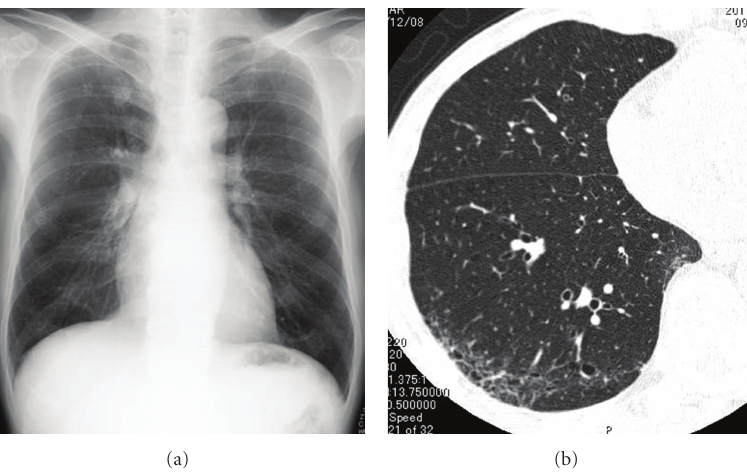
Figure 5: Airway-centered fibrosis with cysts. (a) Chest X-ray shows increased volume of bilateral lungs. (b) High-resolution computed tomography (HRCT) of lower lung shows ground glass opacity and multiple cysts in subpleural region, but these abnormal opacities are predominant in centrilobular region (centrilobular